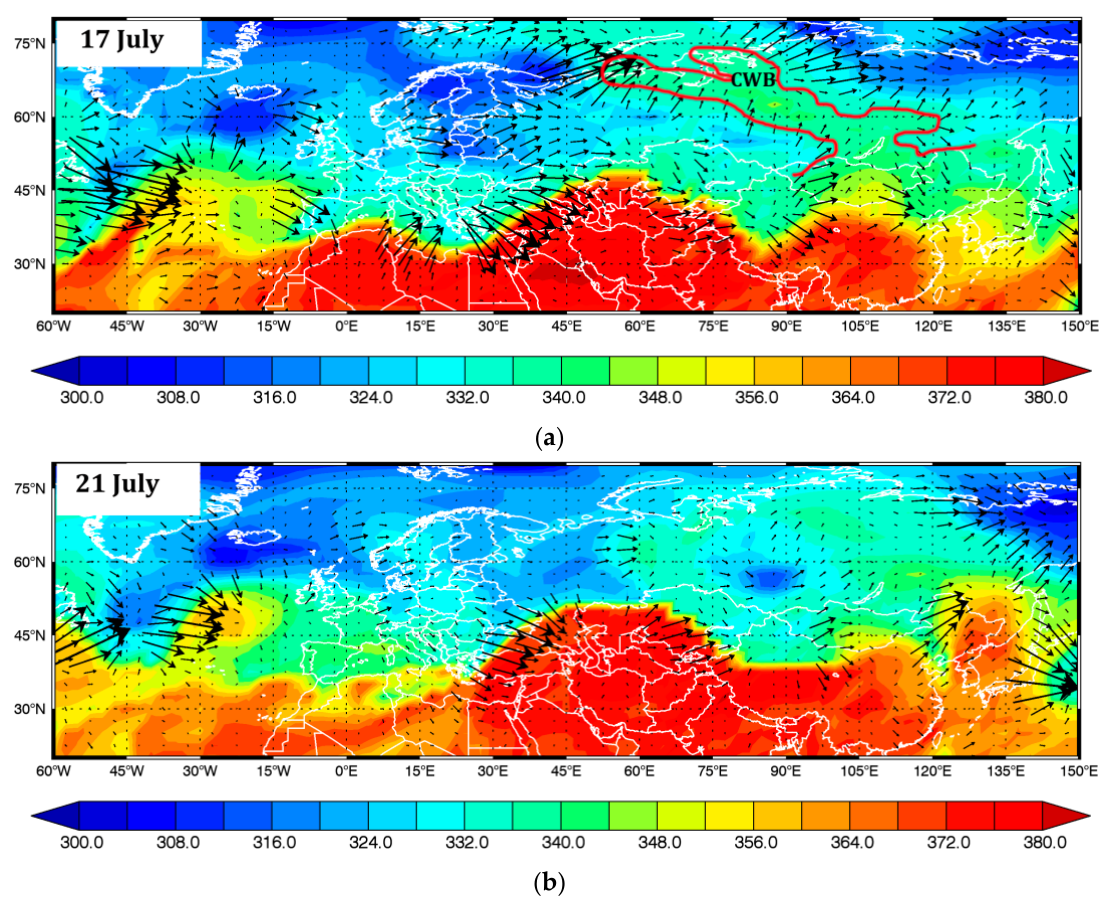
Figure 10. Circulation pattern (WAF and PV- Θ , K) on 17 ( a ) and 21 ( b ) July (4th period). Era-Interim data.